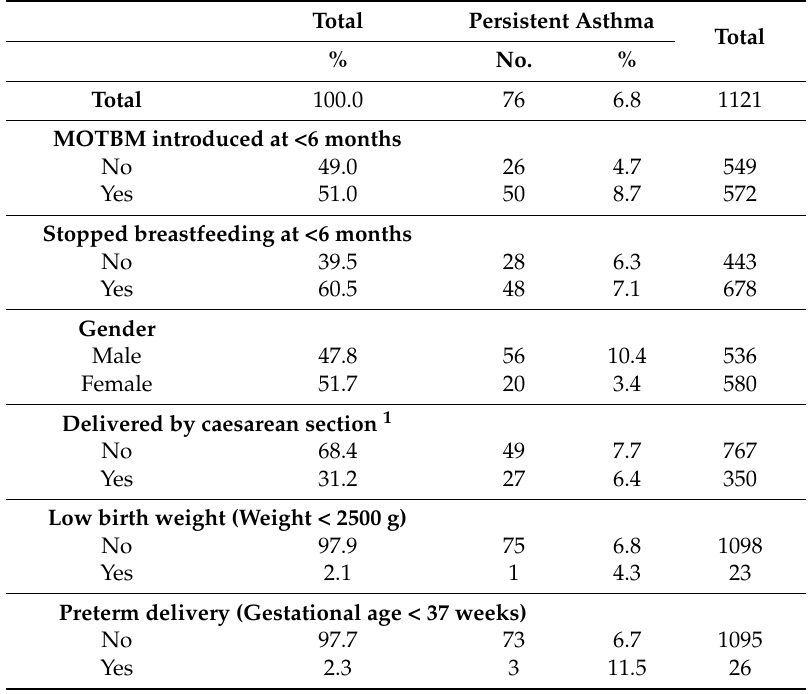
Table 1. Characteristics of children: overall and those with persistent asthma at end of follow-up.